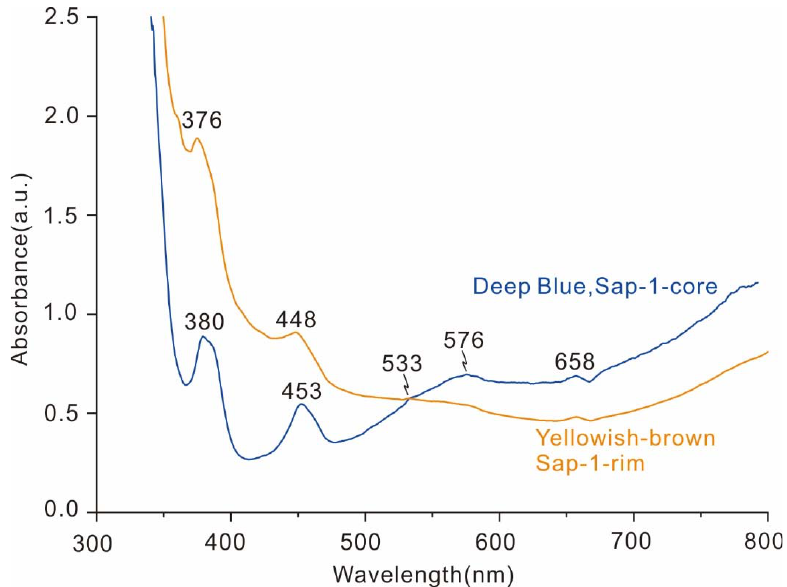
Figure 6. Ultraviolet and visible absorption spectra of the dark ‐ blue core and yellowish ‐ brown rim from Penglai sapphire (sample Sap ‐